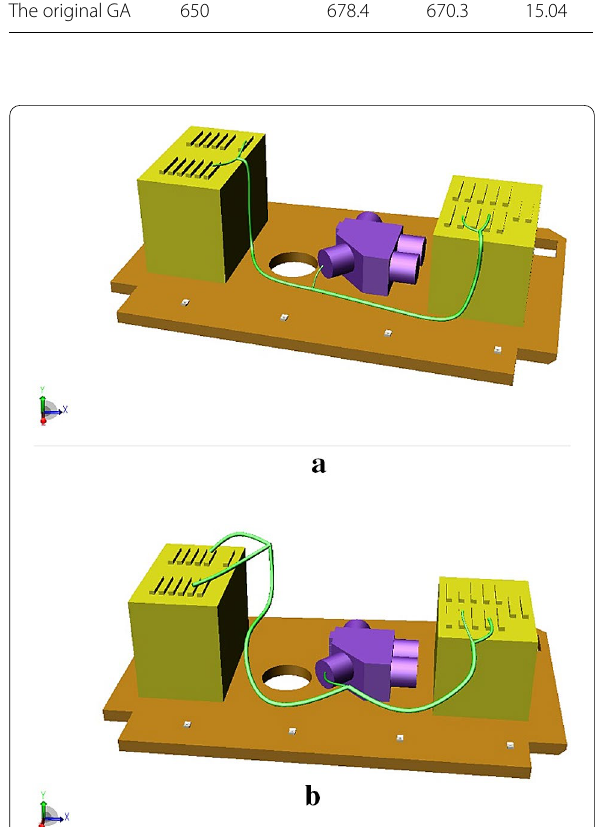
Figure 12 The configuration of the cable harnesses: a configuration of the cable harness designed by the GA in this paper, b configuration of the cable harness designed by the original